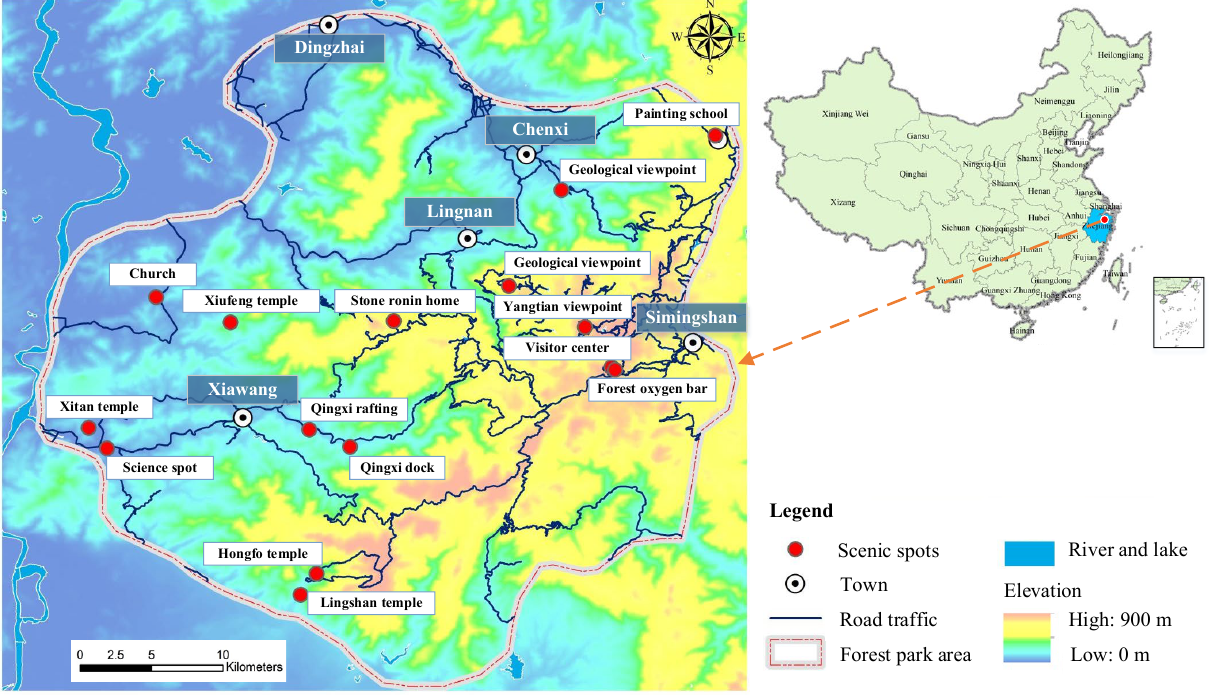
Figure 2. The Map of the Siming Mountain.